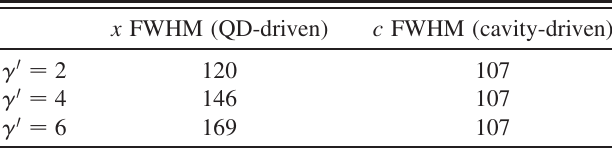
TABLE III. Dependence on the x=c FWHM of the power- TABLE VI. Dependence on the c FWHM of the power- broadened line shape on (cid:7) 0 , for a QD-driven cavity-measured broadened PL intensity of a cavity-driven QD-measured system ¼ 3 meV ), and for a cavity- ¼ 0 : 5 meV ), on the two Lindblad processes, (cid:3) (cid:1) þ a PL system ( x FWHM, with (cid:1) ( (cid:1) cx cx ¼ 0 : 5 meV ). The driven QD-measured PL ( c FWHM, with (cid:1) cx other QD-cavity parameters are the same as in Table I, and all units are in (cid:8) eV .